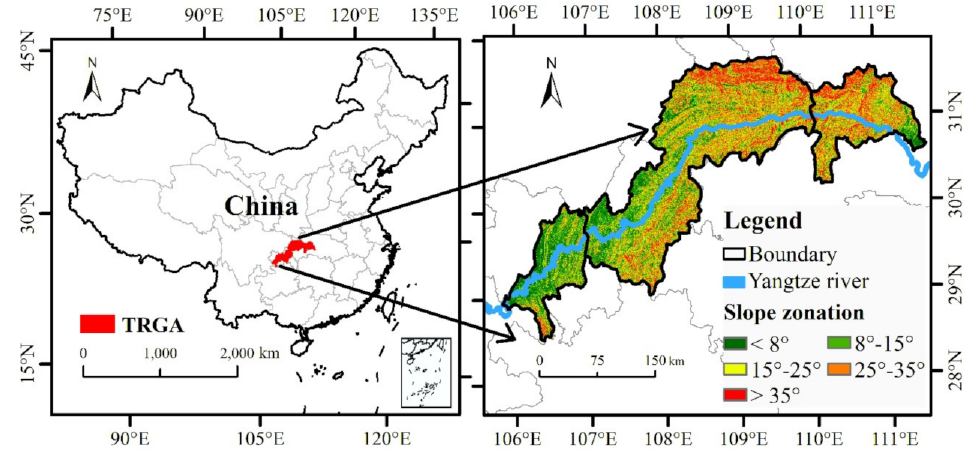
Figure 1. Geographical location of the study